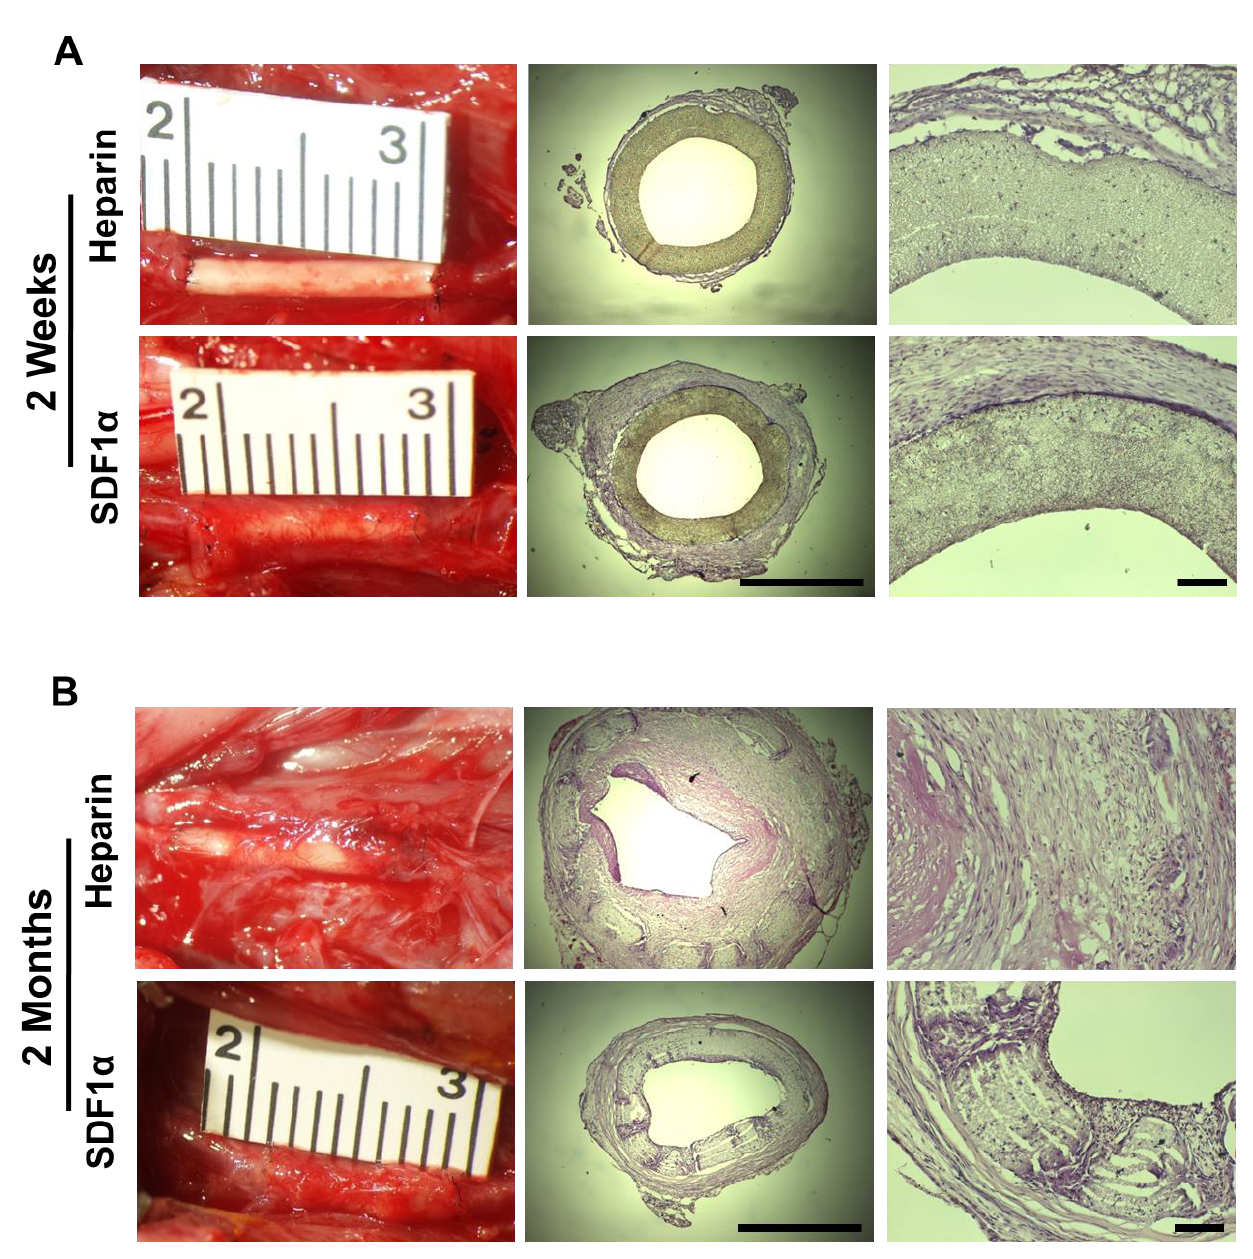
Figure 7. Tissue ingrowth and cell infiltration of vascular grafts. Vascular grafts explanted at ( A ) 2 weeks and ( B ) 2 months for the heparinized ( top ) and SDF-1α immobilized ( bottom ) group. Representative images of grafts in situ taken immediately prior to explantation ( left ) and H&E staining of the cross-section of explanted grafts at low ( middle , scale bar = 1 mm) and high ( right , scale bar = 100 μm) magnification.